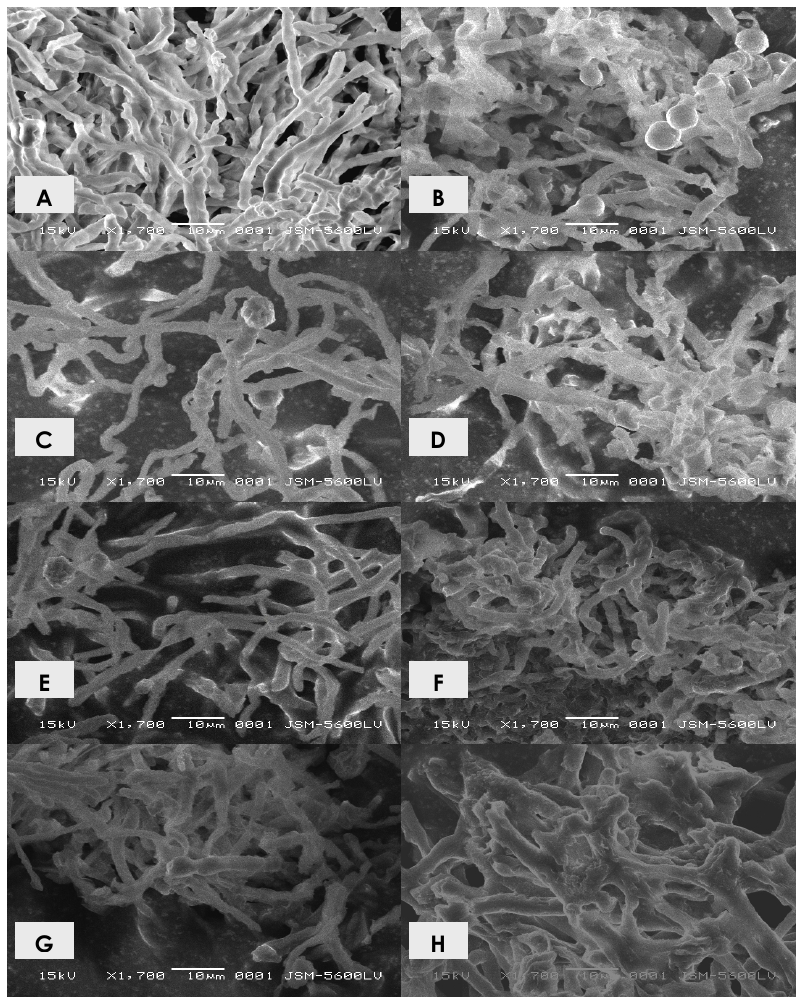
Figure 4. Electronmicrographs of Trichoderma harzianum . A. Control sample 3 days; B. Control sample 15 days; C. Sample grown in 1 mM of cadmium 3 days; D. Sample grown in 1 mM of cadmium in 15 days; E. Sample grown in 2 mM of cadmium 3 days; F. Sample grown in 2 mM of cadmium 15 days; G. Sample grown in 3 mM of cadmium 3 days; H. Sample grown in 3mM of cadmium in 15 days.